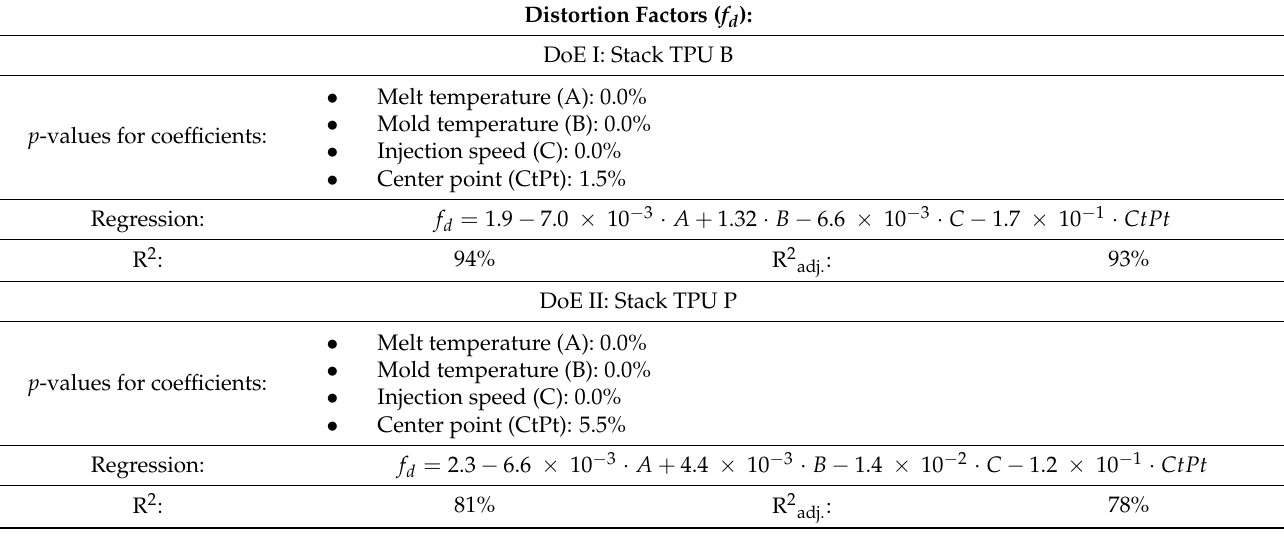
Table 4. ANOVA of DoEs I, II and III in respect to the associated distortion factors f d . Distortion Factors ( f d ):